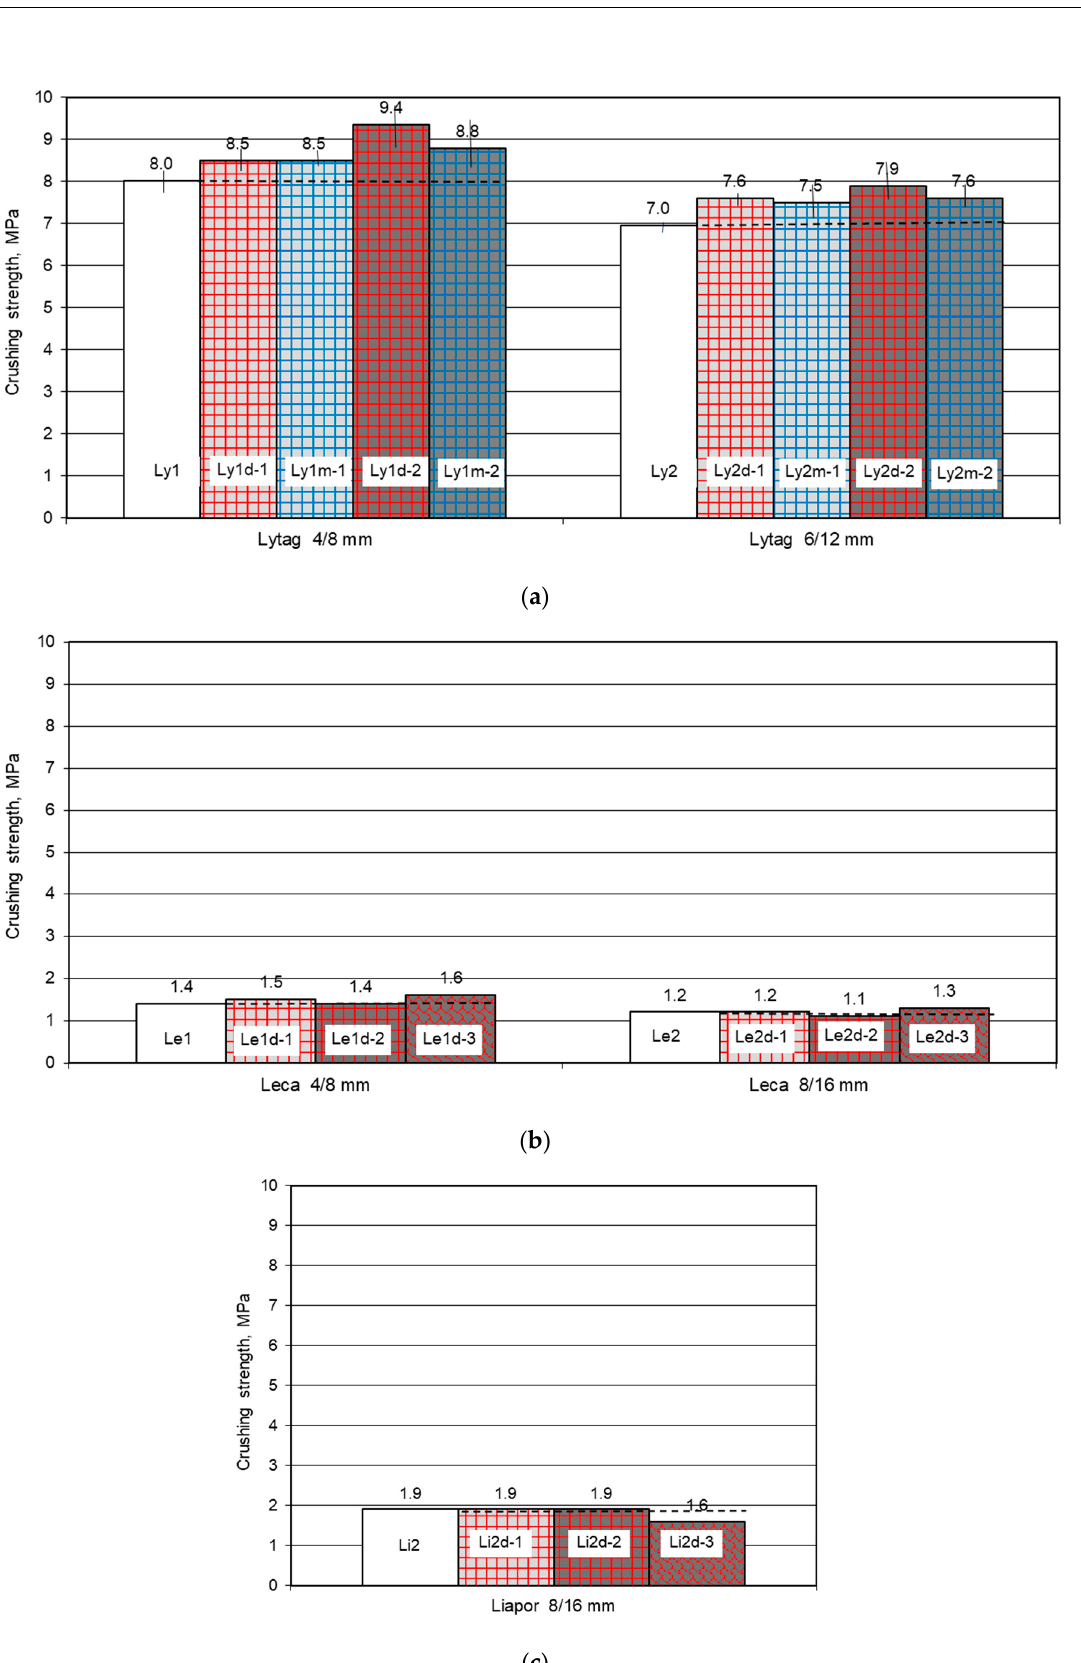
Figure 6. Mean crushing strength of lightweight aggregates, plain and impregnated with cement pastes: ( a ) Lytag, ( b ) Leca, ( c ) Liapor.